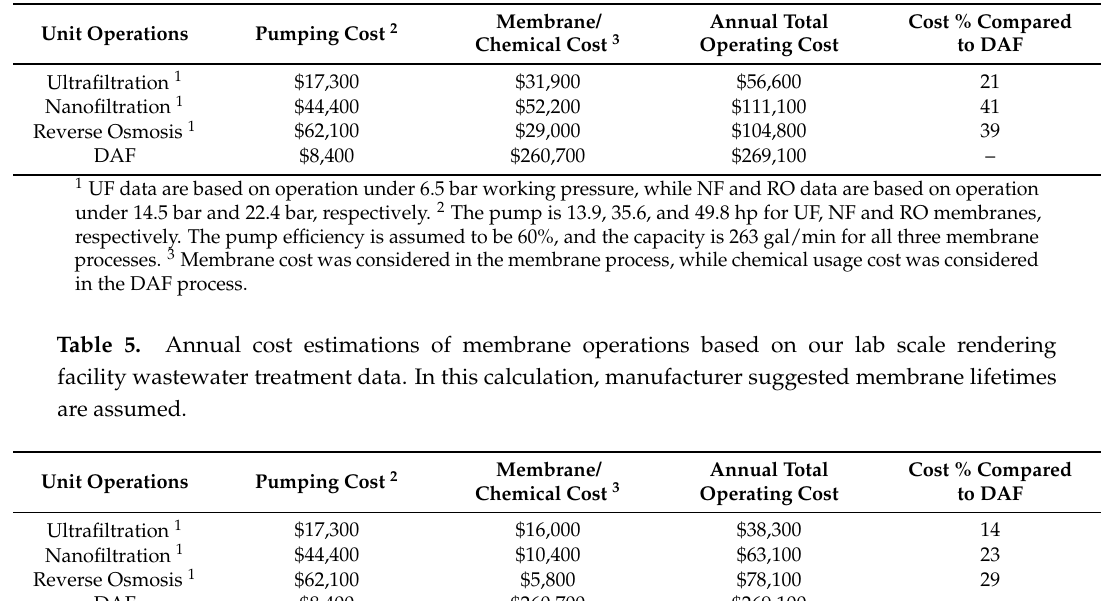
Table 4. Annual cost estimations of membrane operations based on our lab scale rendering facility wastewater treatment data. In this calculation, membrane lifetimes are assumed to be only 1 year.